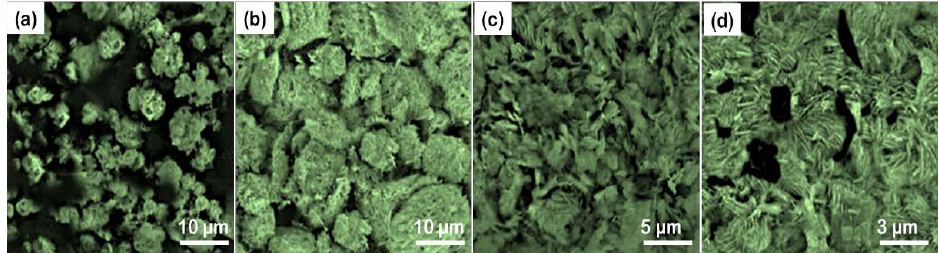
Figure 6. SEM micrographs showing ( a ) BWO − 1 , ( b ) BWO − 2 , ( c ) BWO − 3 , and ( d ) BWO − 4 .